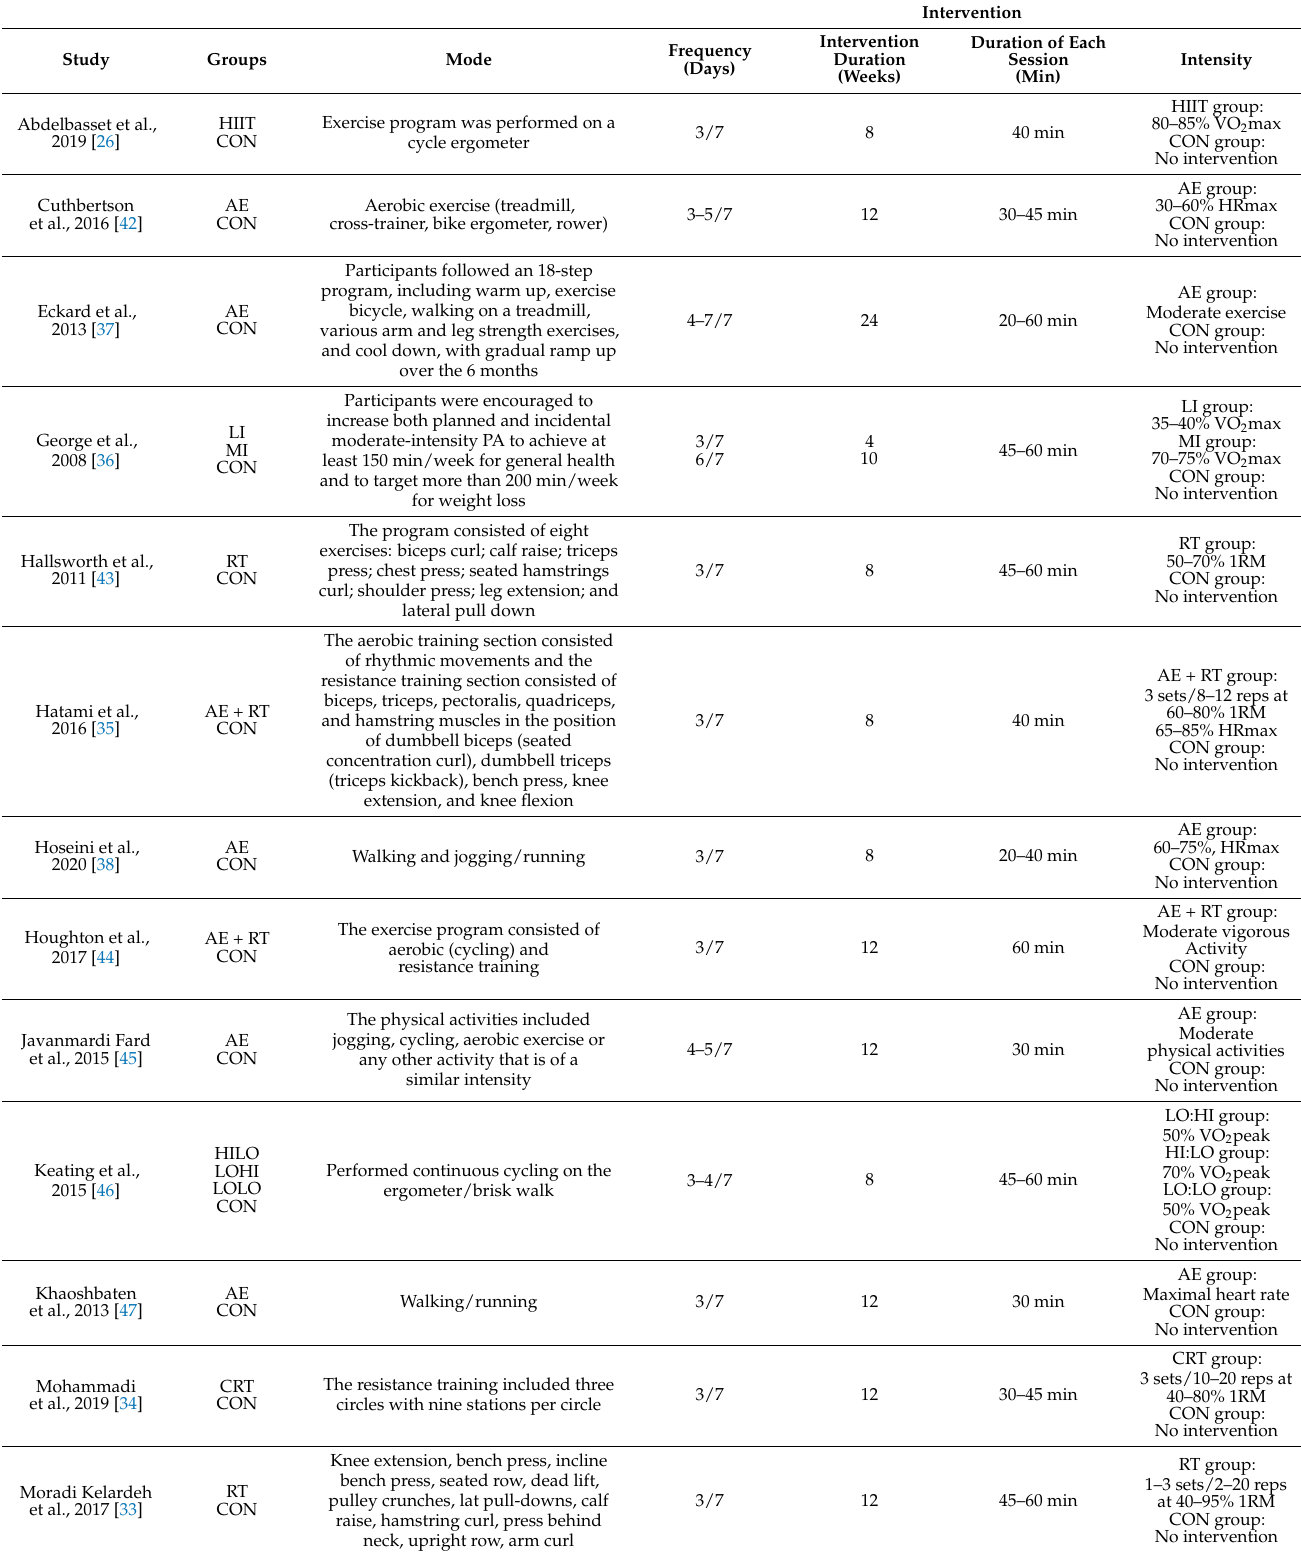
Table 2. Exercise intervention